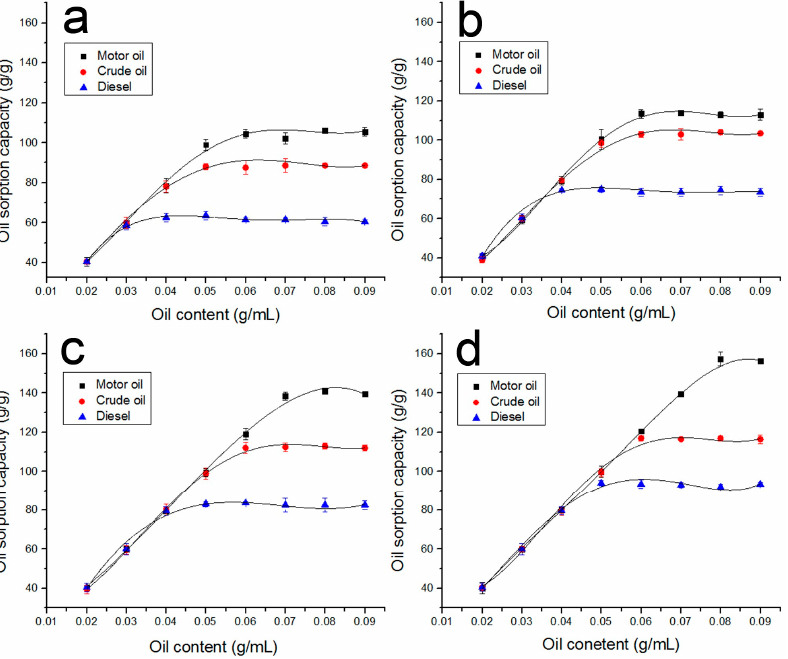
Figure 8. Effect of oil concentration on oil sorption capacity by raw PLA fiber ( a ); (8% H201)/PLA fiber ( b ); (8% H202)/PLA fiber ( c ); and (8% H203)/PLA fiber ( d ).